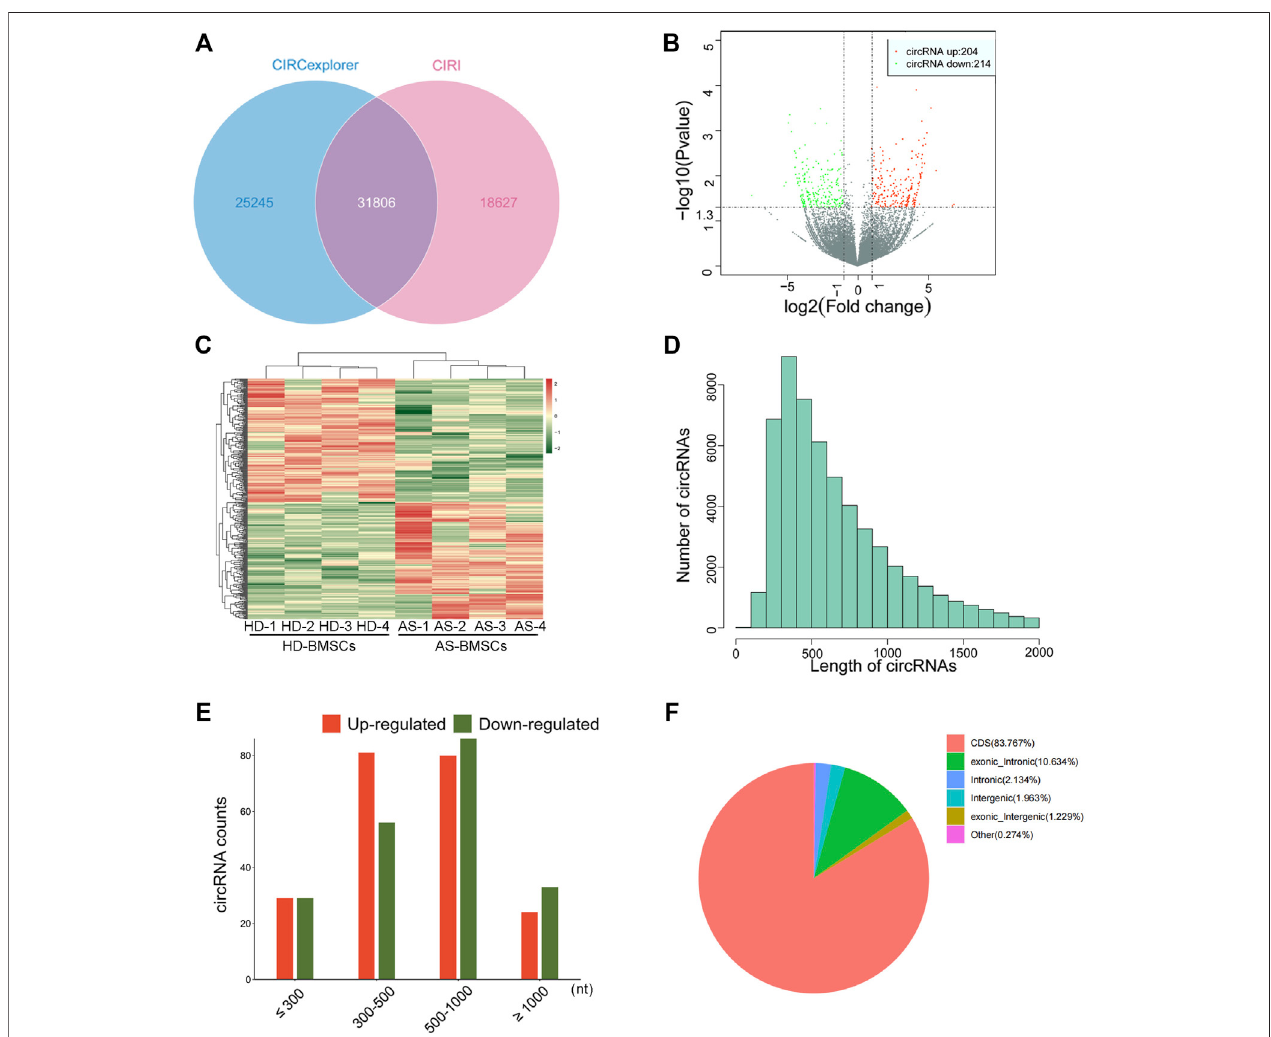
FIGURE 2 | Differential expression pro fi les of circRNAs in HD-BMSCs and AS-BMSCs identi fi ed by RNAseq. (A) . Venn diagram showing circRNAs identi fi ed by bothCIRI2andCIRCexplorer2. (B) .VolcanoplotsofDEcircRNAsinHD-BMSCsandAS-BMSCs.Theverticallineindicatesa2.0-fold(log2scale)change;thehorizontal line represents the p value of 0.05 (-log10 scale). Red dots indicate the upregulated circRNAs. Green dots indicate the downregulated circRNAs. (C) . Heatmap of distinguishable and clustered circRNAs in HD-BMSCs and AS-BMSCs. (D) . The number of circRNAs of different lengths (nt). (E) . Number of upregulated and downregulated circRNAs based on nucleotide length (nt). (F) . Classi fi cation of the identi fi ed circRNAs by CIRI2 based on genomic